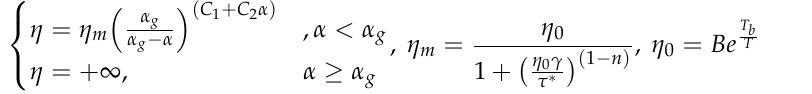
Figure 3. Finite element model of the resin cavity.